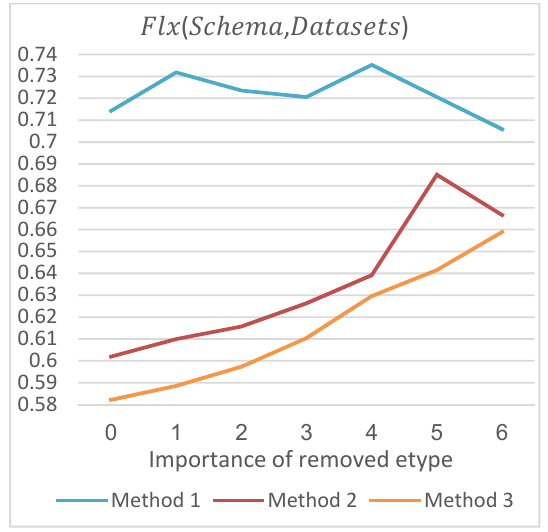
Figure 11. Flexibility of Schema to Datasets.